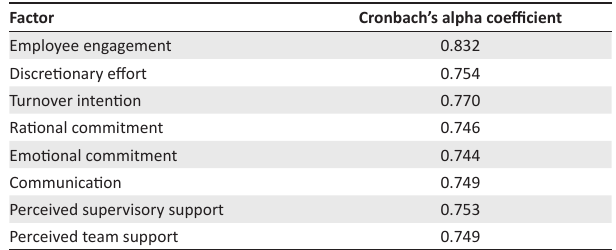
TABLE 1: Cronbach’s alpha coefficient scores.